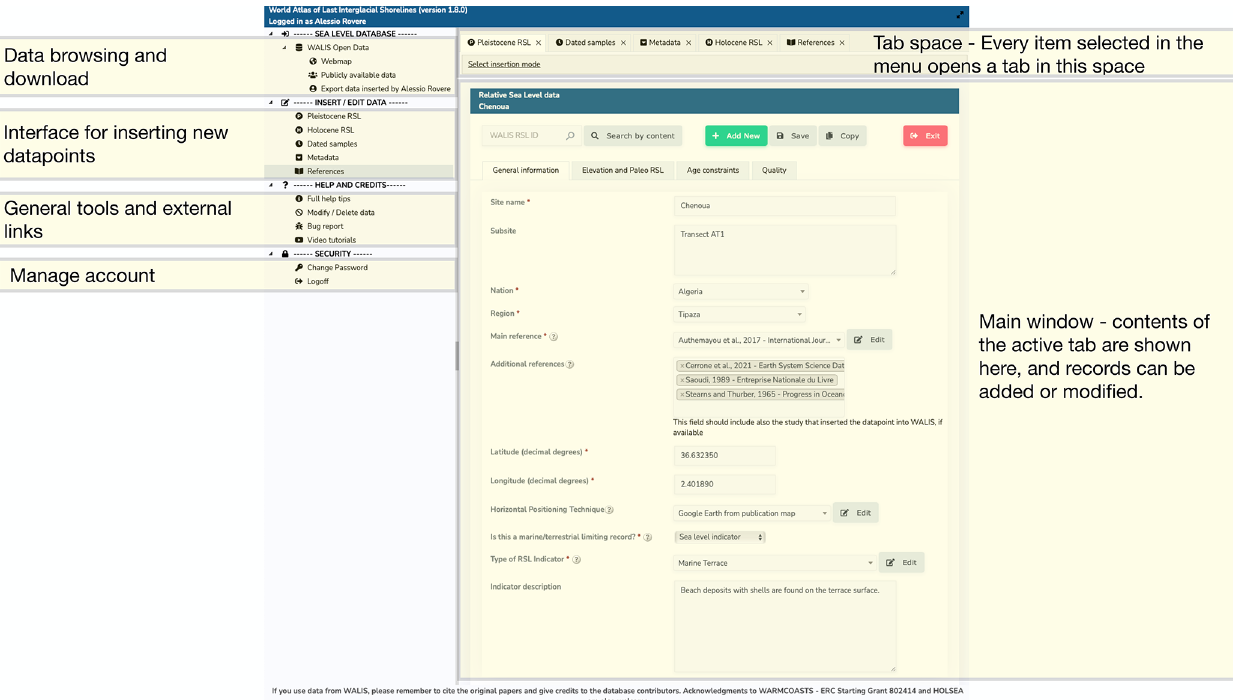
Figure 4. Annotated screenshot of the WALIS PHP interface, version 1.8.0.